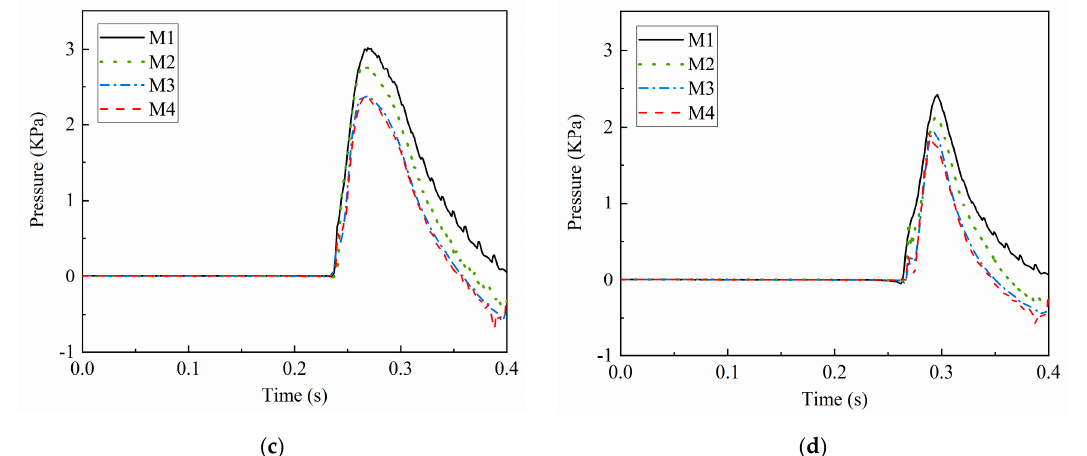
Figure 6. Impact forces and impact pressures of “S2” with different mesh densities: ( a ) impact force;